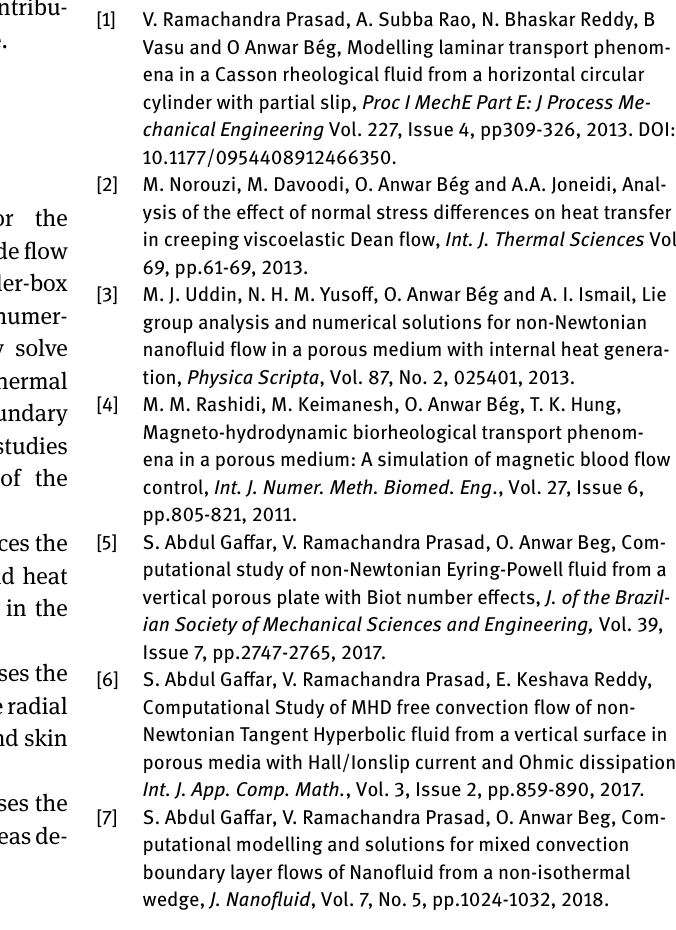
Fig. 13(a)–13(b) depict the influence of the